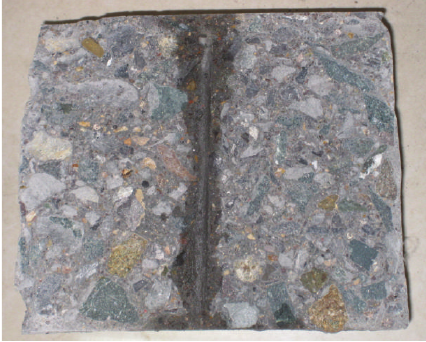
Figure 4: Solution transport